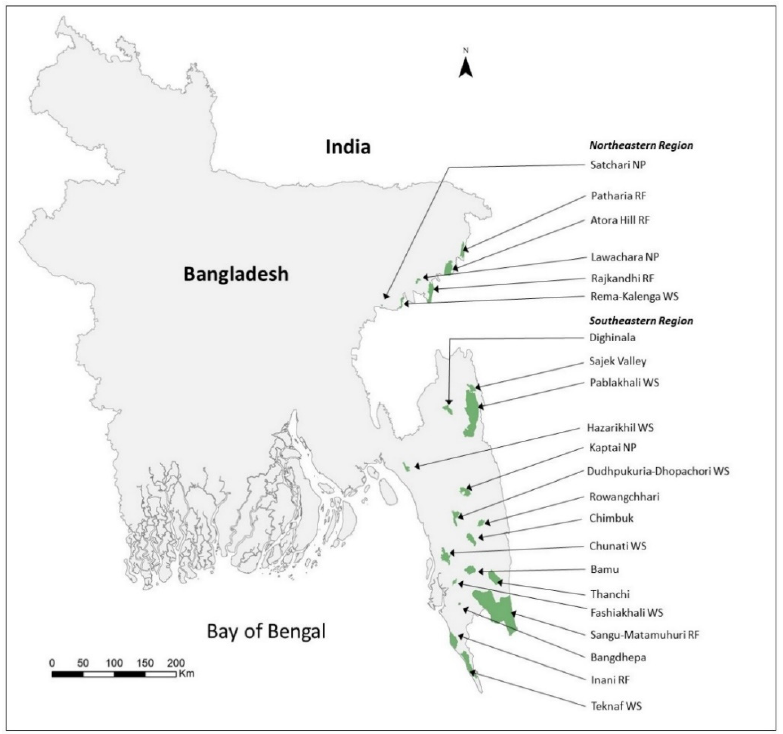
Figure 1. Map showing the study sites in northeastern and southeastern Bangladesh. The areas consisted of closed canopy forest patches suitable for western hoolock gibbon that were surrounded by human habitation or farmlands. NP = National Park, WS=Wildlife Sanctuary, RF= Reserve Forest.